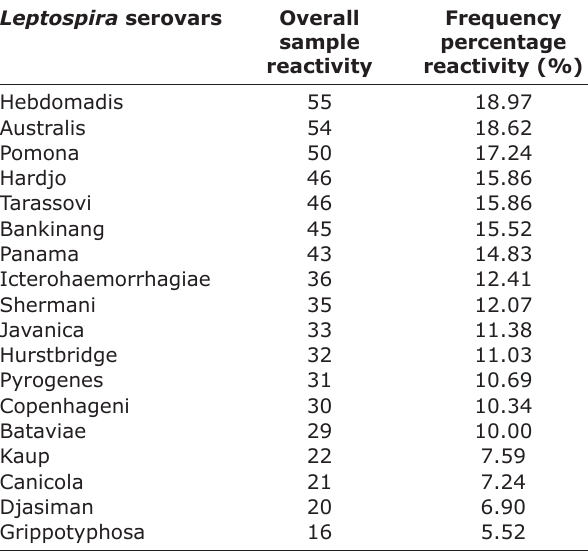
Table-2: Frequency percentage distribution of reacted pathogenic serovars in cattle and buffaloes in endemic districts of Andhra Pradesh.